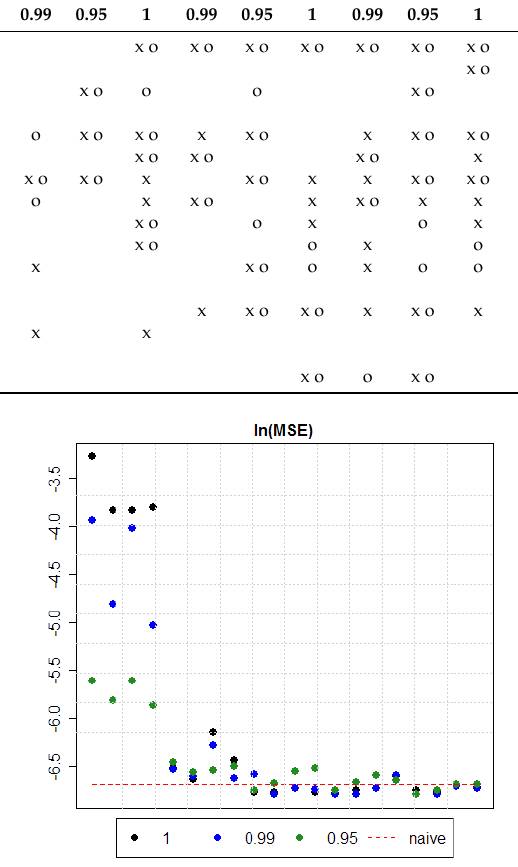
Figure 1. Prediction quality: ln(MSE) for models with different values of the forgetting factor.